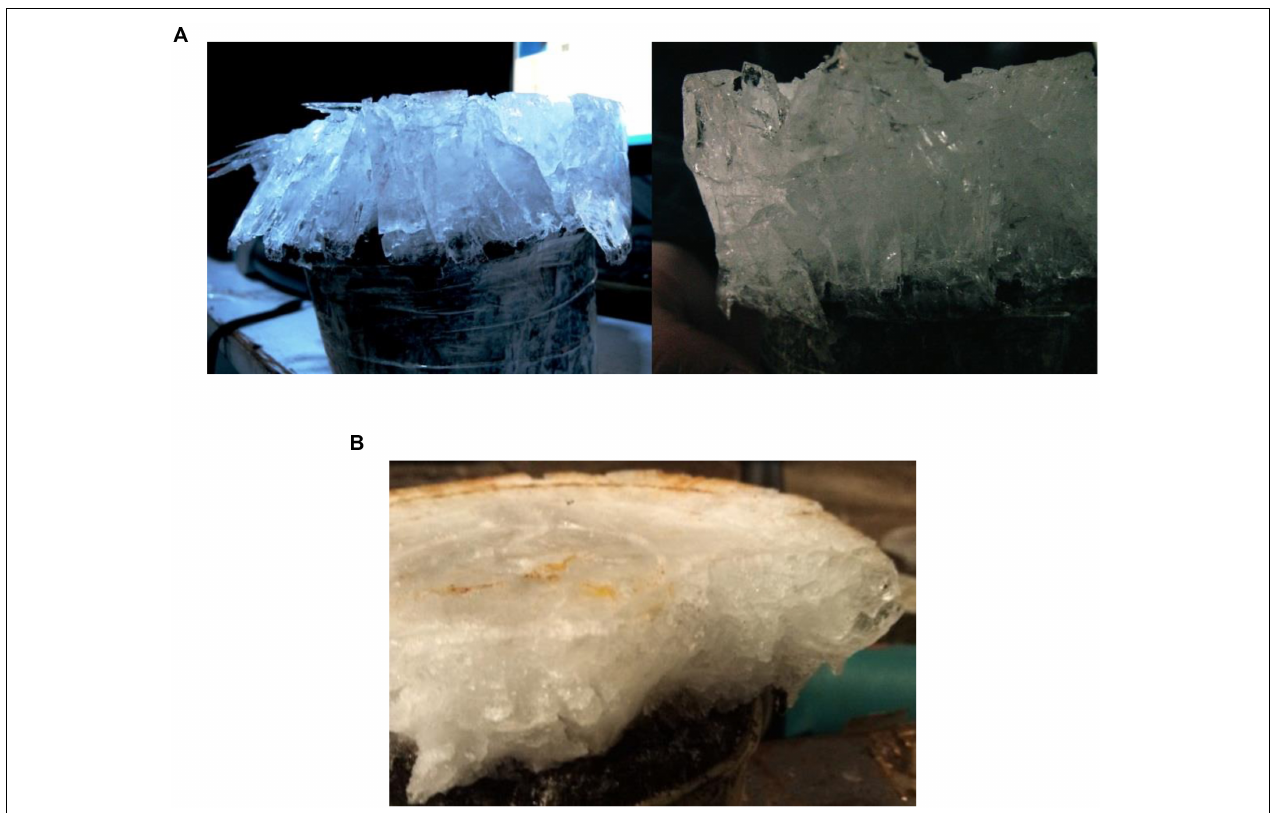
FIGURE 12 | (A) Ice configuration after compression for lower ice temperature. (B) Ice configuration after compression for higher ice